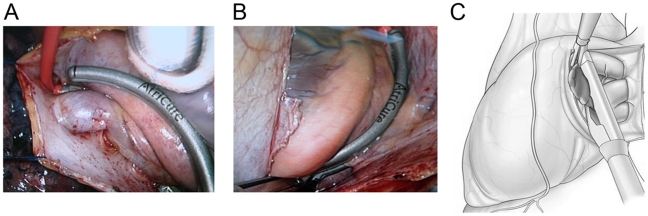
Video-assisted thoracoscopic surgical ablation.(A) Right thoracoscopic view of the bipolar clamp in place on the left atrial antrum, medial to the right PV. (B) Left thoracoscopic view of the bipolar clamp in place on the left atrial antrum, medial to the left PV. (C) The left atrial appendage is excised by stapling it with a stapler.